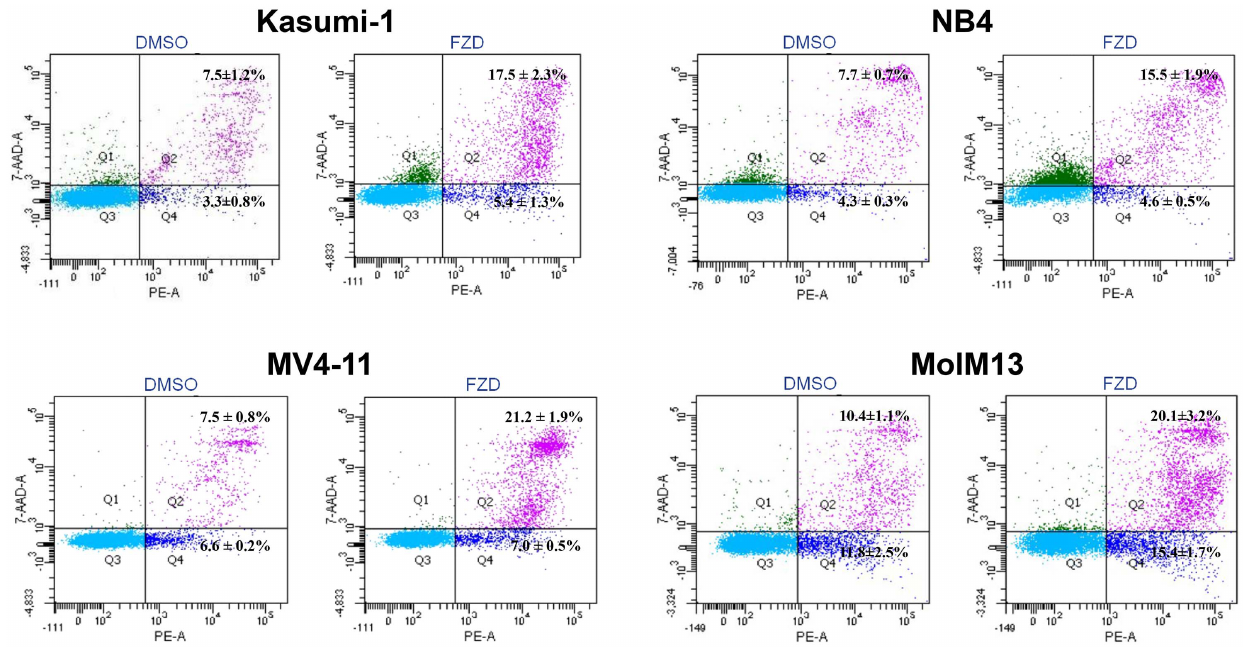
Figure 3. Furazolidone induces apoptosis of AML cells. The apoptosis was measured by Annexin V-PE/7-AAD kit using FACS in Kasumi-1, NB4, MV4-11 and MolM13 in the presence of DMSO control or the predetermined IC50 value of FZD for 72 hours.There are reports that FZD can inhibit cell proliferation and provokes apoptosis by inducing S-phase arrest in human hepatoma G2 cells [14]. We therefore tested whether FZD could also cause cell-cycle arrest in AML cells. We treated AML cells with FZD at the predetermined IC50 value and analyzed by flow cytometry. We showed that this compound did not modulate cell-cycle distribution (Figure S1), suggesting that it prolonged cell-doubling time rather than inducing cell-cycle arrest.